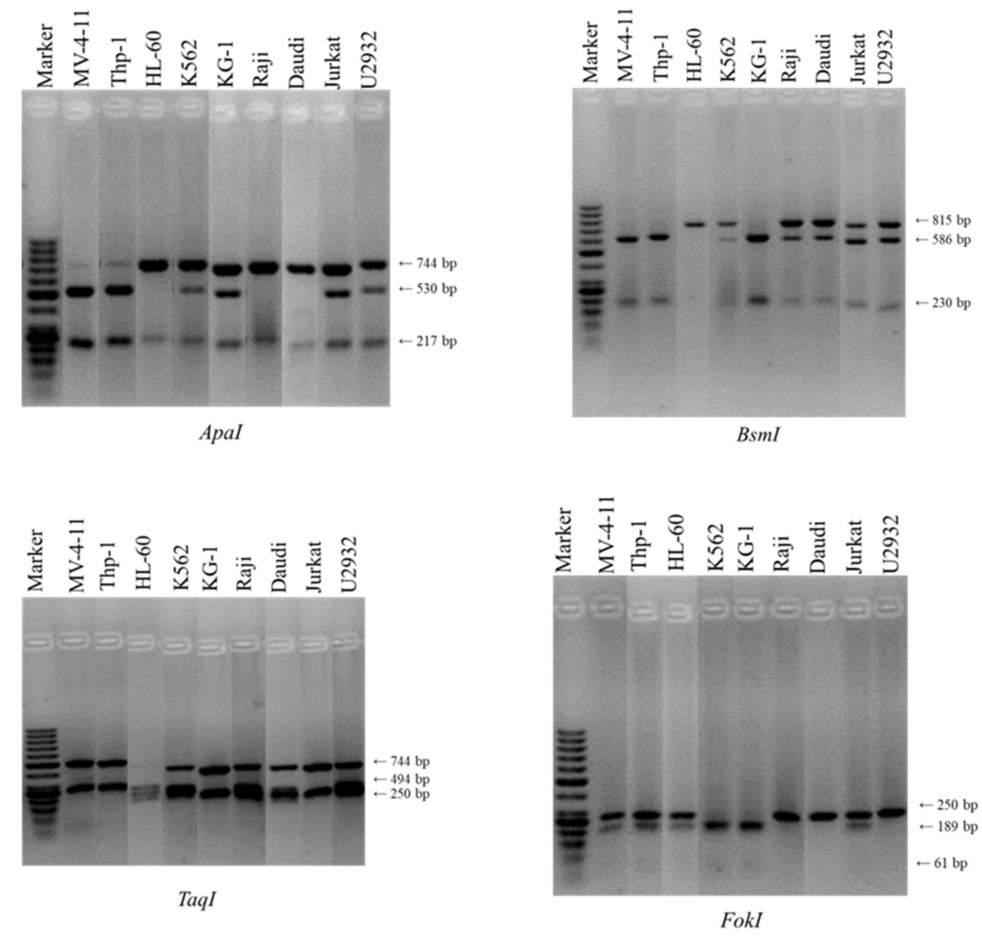
Figure 7. Polymorphism of vitamin D receptor. Alleles are shown of human leukemia and lymphoma cells in the gene coding for the vitamin D receptor. Above are examples of RLFP patterns (M-marker mass, numbers from 1–9 cell lines, names are given in the table). For easier tracking of the results, the gel photos were cut and arranged in order of lines responding and not responding to the use of calcitriol and tacalcitol. Gels before processing are presented in Figure